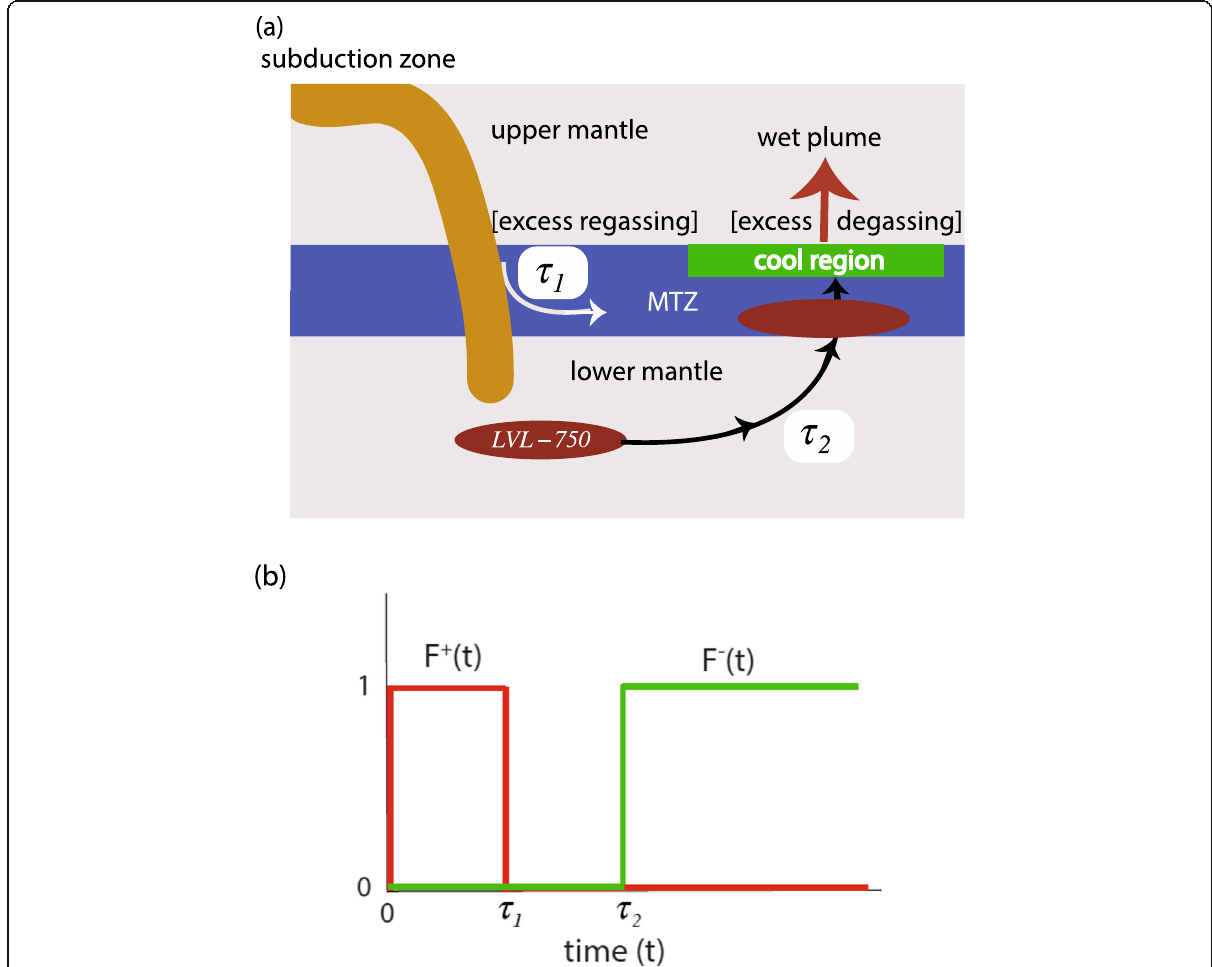
Fig. 12 Model of global water circulation involving deep mantle melting. a A schematic diagram of water circulation. Excess regassing occurs associated with cold subduction ( τ 1 : duration of excess regassing). This produces partial melting in the lower mantle (LVL-750). Due to the change in plate boundary geometry (associated with supercontinent cycle (Lithgow-Bertelloni and Richards 1998), the hydrated and buoyant materials will be transported to the MTZ, and when these materials reach to ~ 410 km, excess degassing starts (after τ 2 since the beginning of the excess regassing (this is controlled largely by the time scale of change in plate boundary geometry)). b D efinition of two functions: Γ + ( t ) a